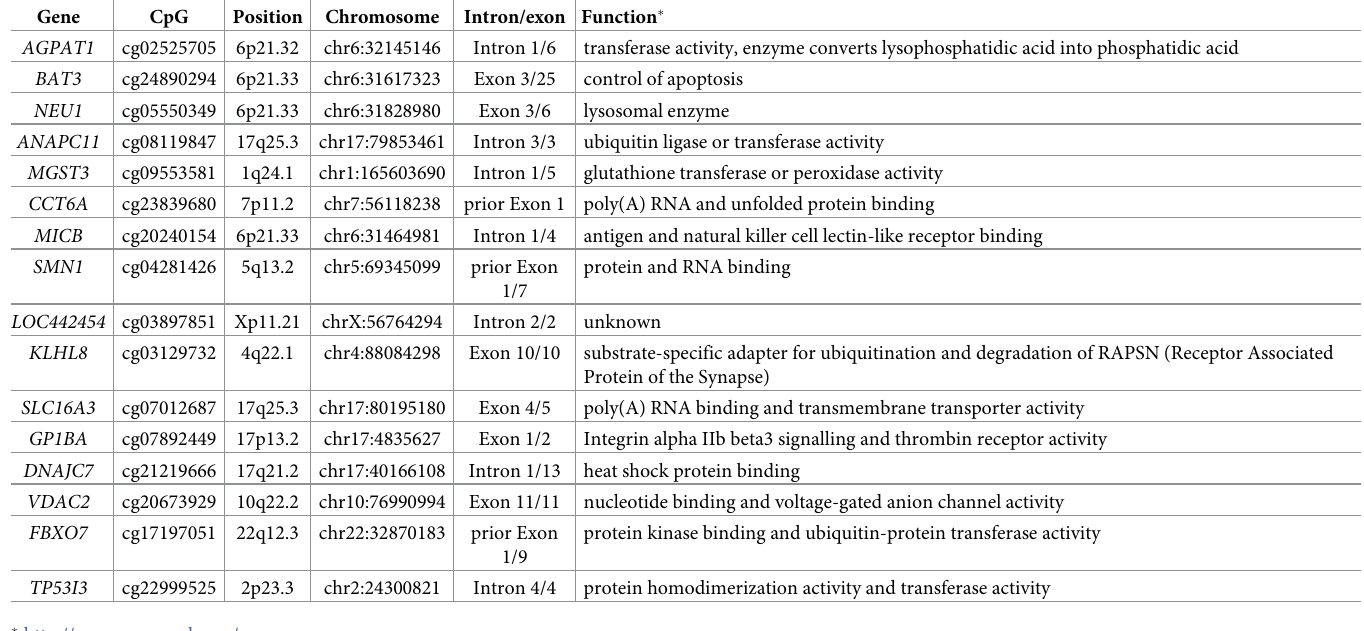
Table 3. Location and function of genes with RIDM (minimum-change 3%) and RIRE (minimum-change 0.1 RPKM) in nasal epithelial cells from children with asthma. Gene CpG Position Chromosome Intron/exon Function